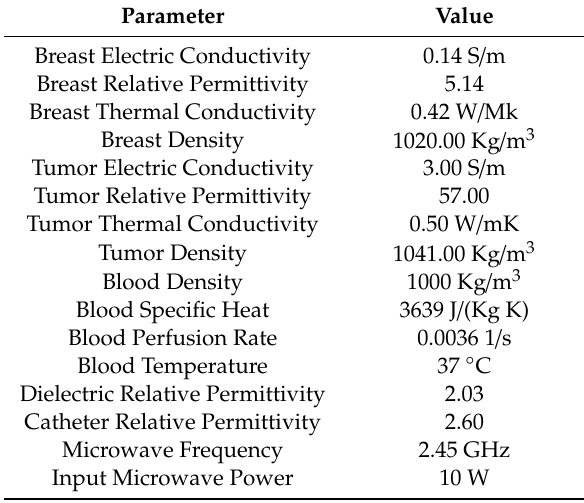
Table 1. Tissue and antenna parameters used in the finite element method (FEM)